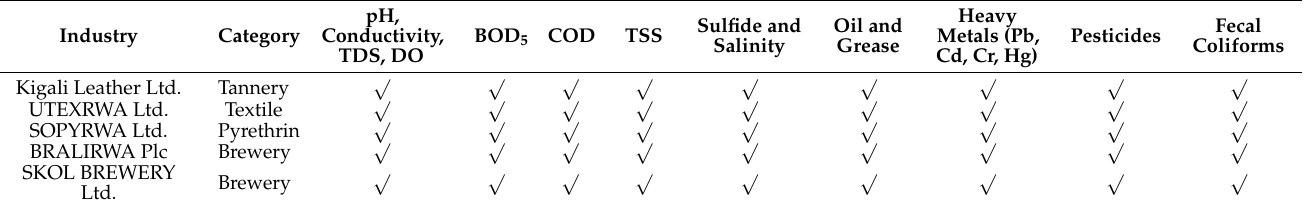
Table 1. Parameters analyzed for the selected